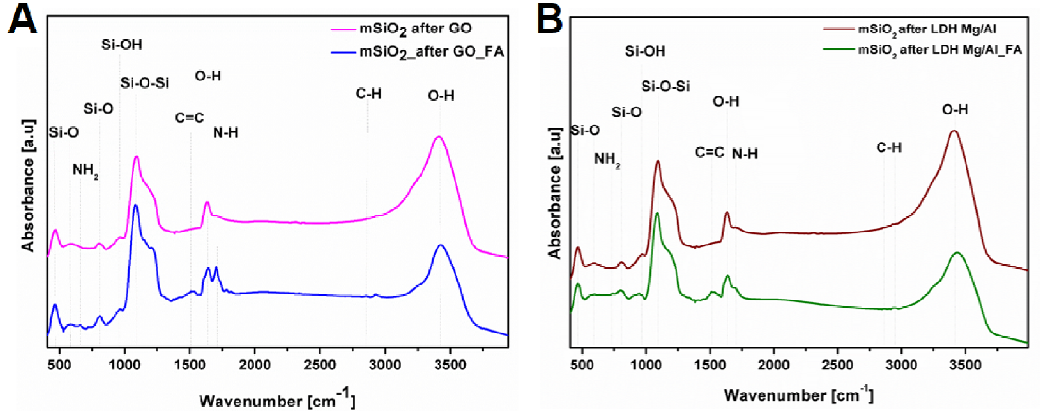
Figure 3. FTIR spectra of silica flakes functionalized with folic acid: mSiO 2 after GO_FA ( A ) and mSiO 2 after LDH Mg/Al_FA ( B ).